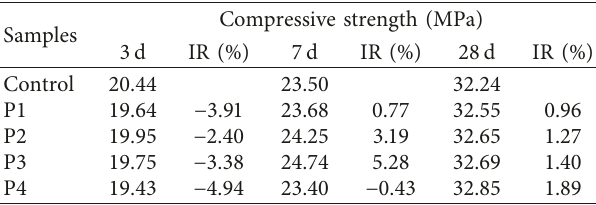
Figure 5: Effect of the PPF content on physical properties of the AAS mortar: (a) apparent porosity, (b) water absorption, and (c) bulk density. The error bars represent the standard deviation of three test specimens. Table 4: Compressive strength of AAS mortars at 3, 7, and 28